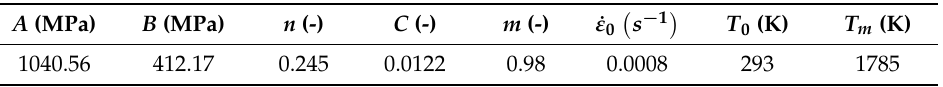
Table 2. Parameters of the Johnson–Cook constitutive relation for the studied high strength